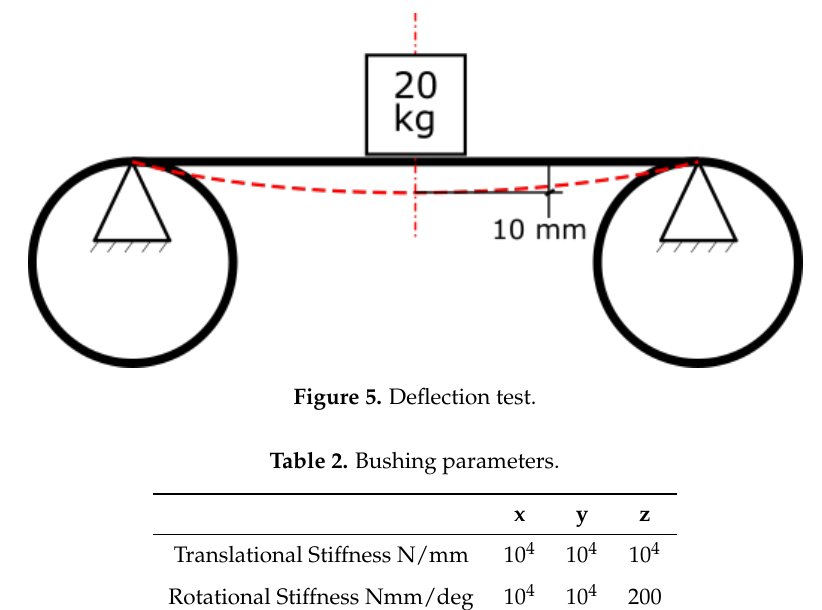
Figure 5. Deflection test. Table 2. Bushing parameters.